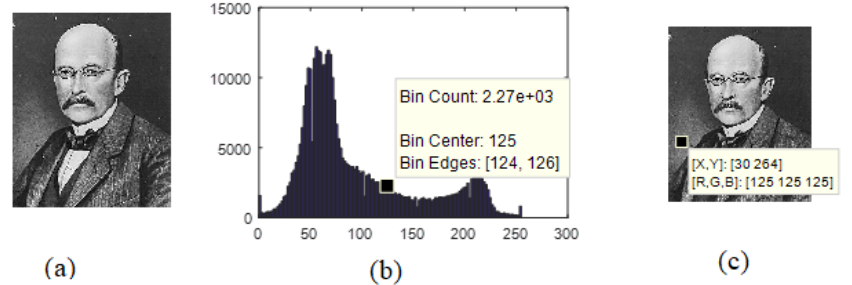
Figure 2. ( a ) Max Planck. ( b ) Histogram of the Max Planck image, and ( c ) pixel mid-distance of the two fuzzy centers.